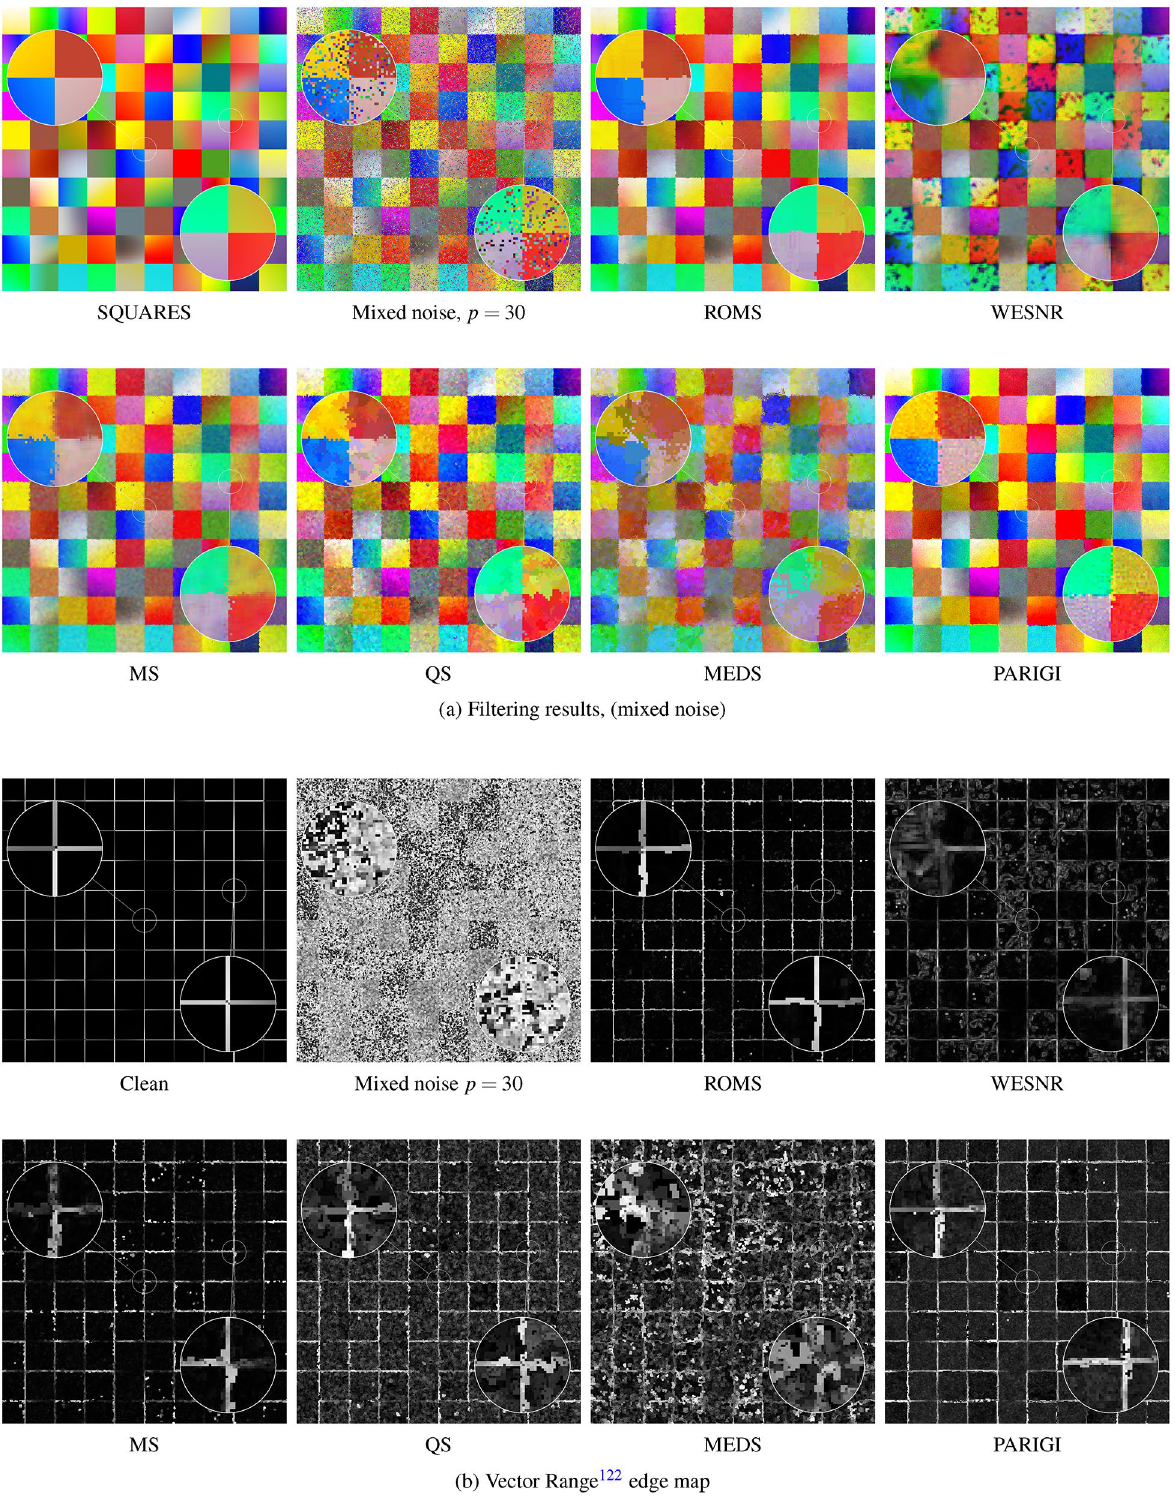
Figure 10. Efficiency comparison of the the proposed ROMS with MS and its fast modifications using the SQUARES test image contaminated with mixed noise p = 30